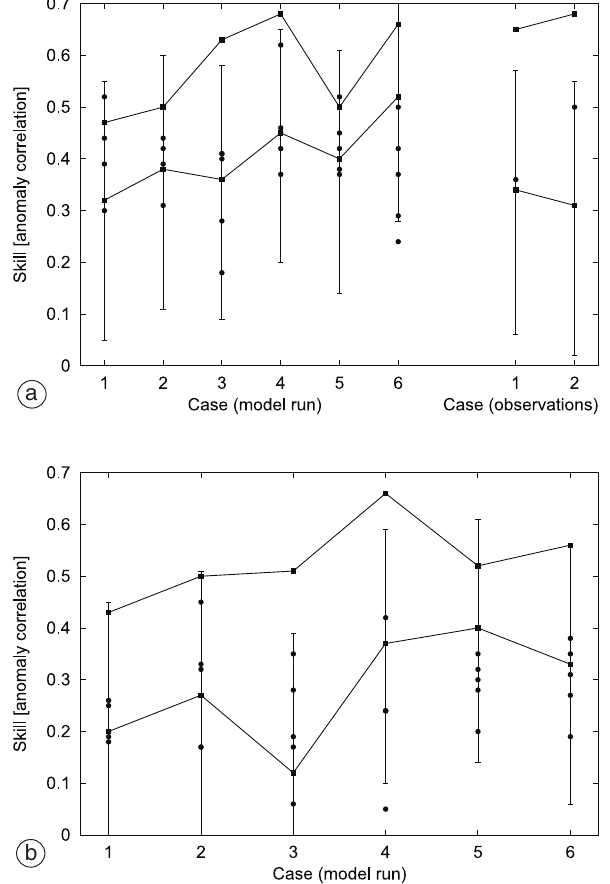
Fig. 15a,b. Predictive skill for statistical predictions of model simulated NAO index in JFM as estimated from six non-overlapping 50-year training periods for the model run (case 1-6). Top curve: validation period identical to training period. Bottom curve: as top curve, but using cross-validation (see text). Error bars: estimated 95% confidence interval for cross validated skill scores. Circles: validation periods not overlapping with training period. a) Predictions based on tropical SST from JFM, i.e . lead time = 0. Predictive skill scores are also included for two non-overlapping 46- year training periods for gridded observations. b) Predictions based on tropical SST from OND, i.e . lead time = 1